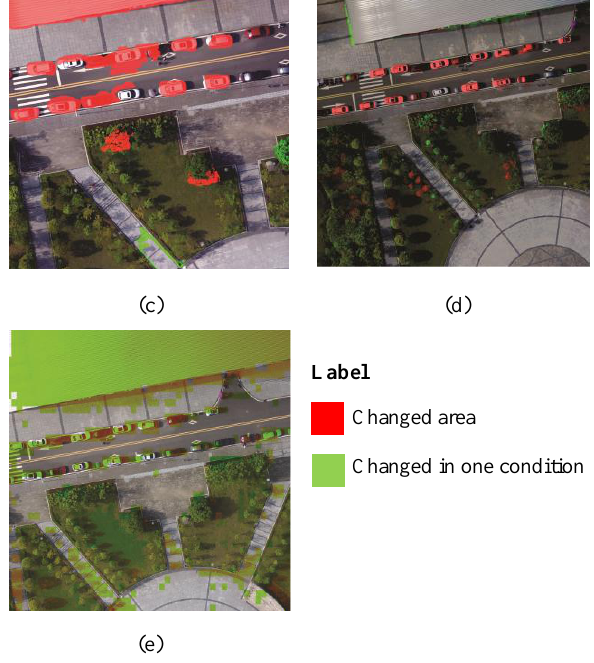
Figure 10. DSM and texture based change detection result from Quad-Rotor